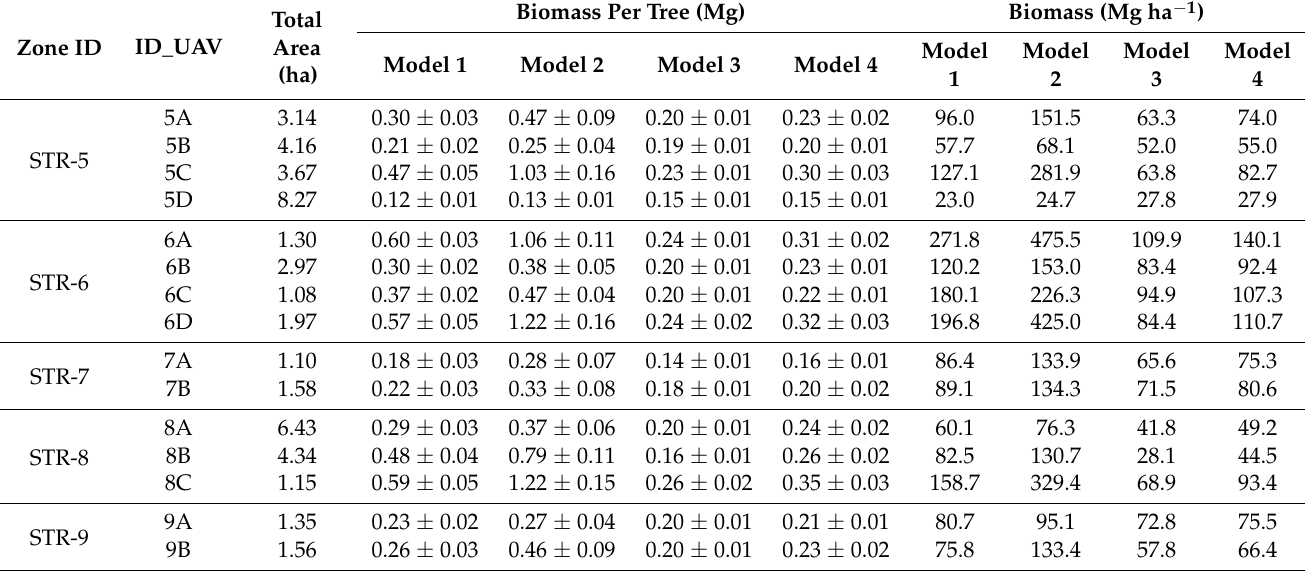
Table 5. Tree average biomass (Mg) and biomass per surface (Mg ha − 1 ) estimated for each UAV flight through the four models previously shown in Table 4.